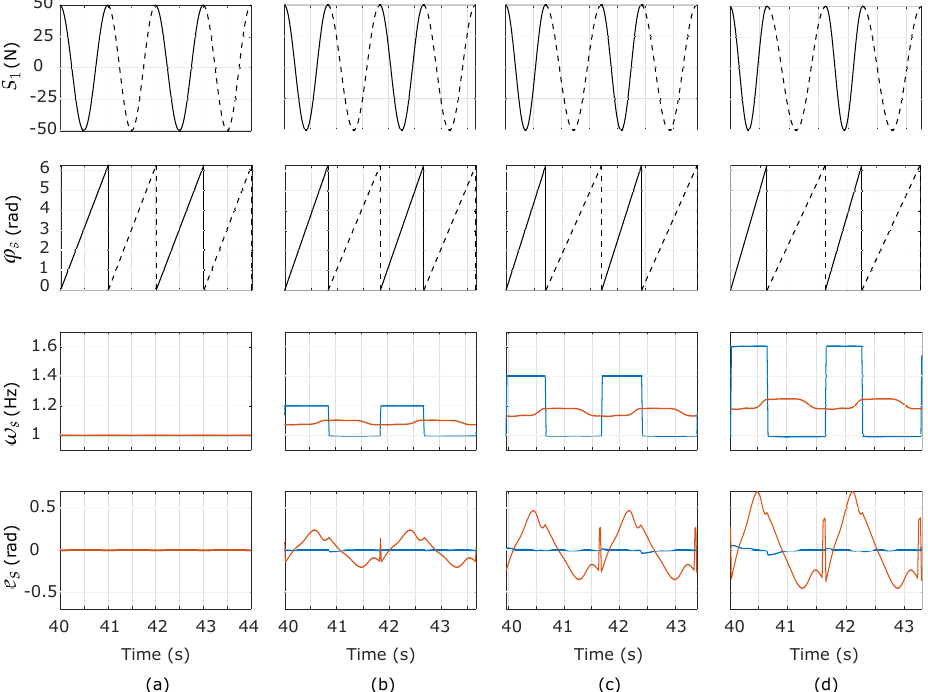
Figure 3. Simulation results with different frequency combinations ( a ) ω s 1 = 1 Hz and ω s 2 = 1 Hz. ( b ) ω s 1 = 1.2 Hz and ω s 2 = 1 Hz. ( c ) ω s 1 = 1.4 Hz and ω s 2 = 1 Hz. ( d ) ω s 1 = 1.6 Hz and ω s 2 = 1 Hz. S 1 is the simulated signal; the black solid line represents the signal with ω s 1 and the black dotted line represents the signal with ω s 2 . ϕ s is the phase of the simulated signal. ω s is the estimated frequency of the AO (Red) and the proposed method (Blue). e s is the phase estimation error of the AO (Red) and the proposed method (Blue).